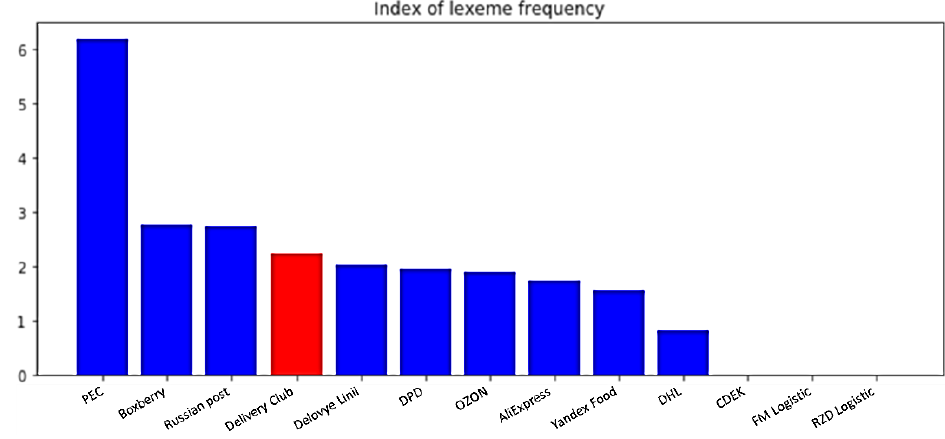
Figure 10. Index of lexeme frequency.